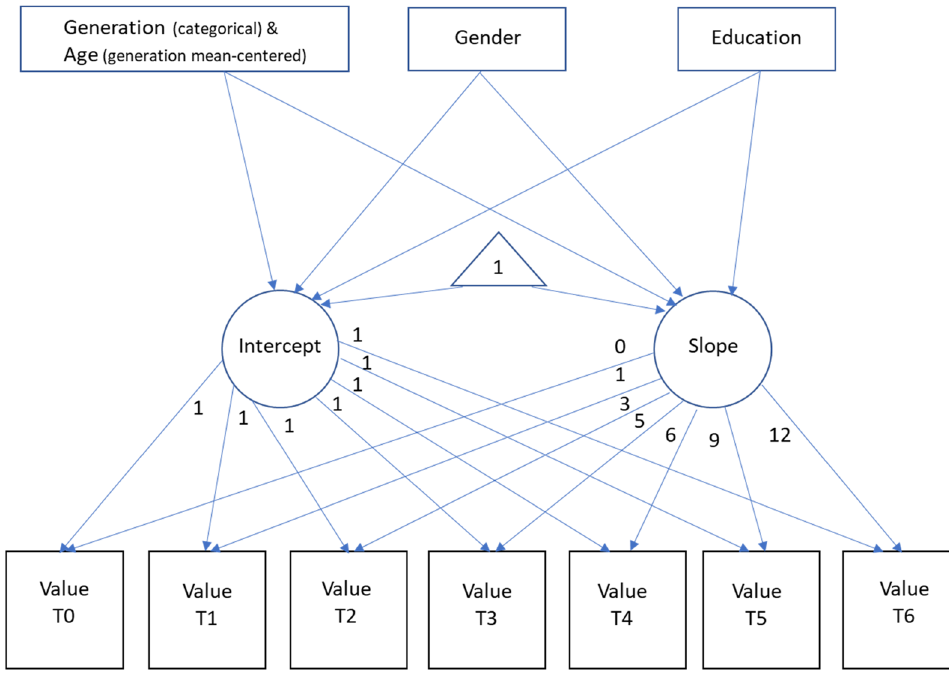
Figure 2. Latent growth model value change over 12 years with latent intercept and slopes.